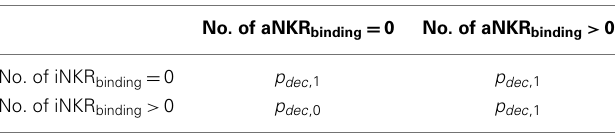
Table 2 | Levels of protection against a decoy virus in the agent-based